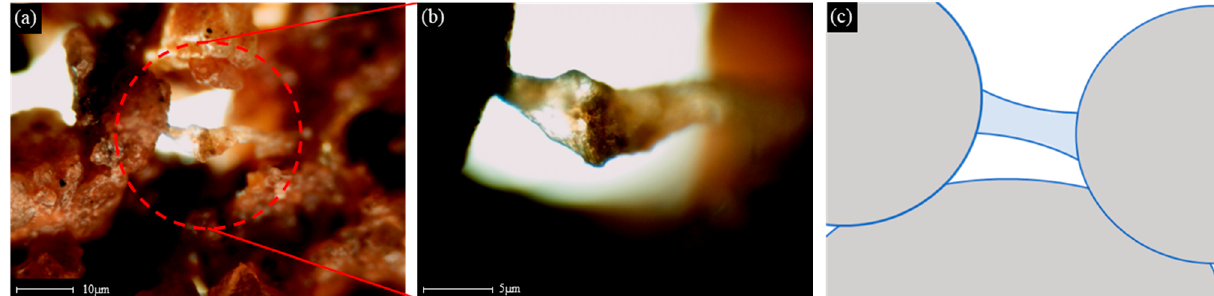
Figure 13. Optical microscope image of sodium alginate reinforced soil particles; ( a ) 4× magnification image of sodium alginate and soil linking; ( b ) 10× magnification image of sodium alginate and soil linking; ( c ) Schematic model of sodium alginate solution treated soil.